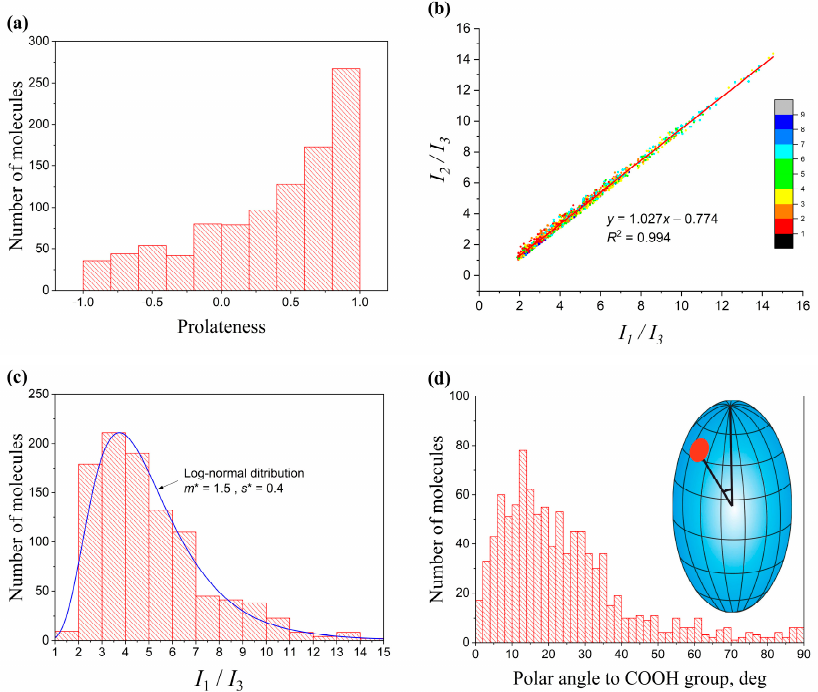
Figure 4. ( a ) Distribution of prolateness P for 1000 AMA molecules in a membrane with initial structure W over the 200–300 ns MD interval; ( b ) Relationship of ratios I 1 / I 3 and I 2 / I 3 for a sample of 1000 structures from 200 to 300 ns MD. The solid line is the bisector I 1 = I 2 (ellipsoid of revolution); ( c ) The distribution of the ratio of maximum and minimum moments of inertia follows a log-normal distribution ( m ∗ and s ∗ are the log-normal mean and standard deviation); ( d ) Representation of an MA molecule as an ellipsoid with the position of the COOH group (red circle) and the histogram of the polar angles of the COOH group on the ellipsoid of inertia.